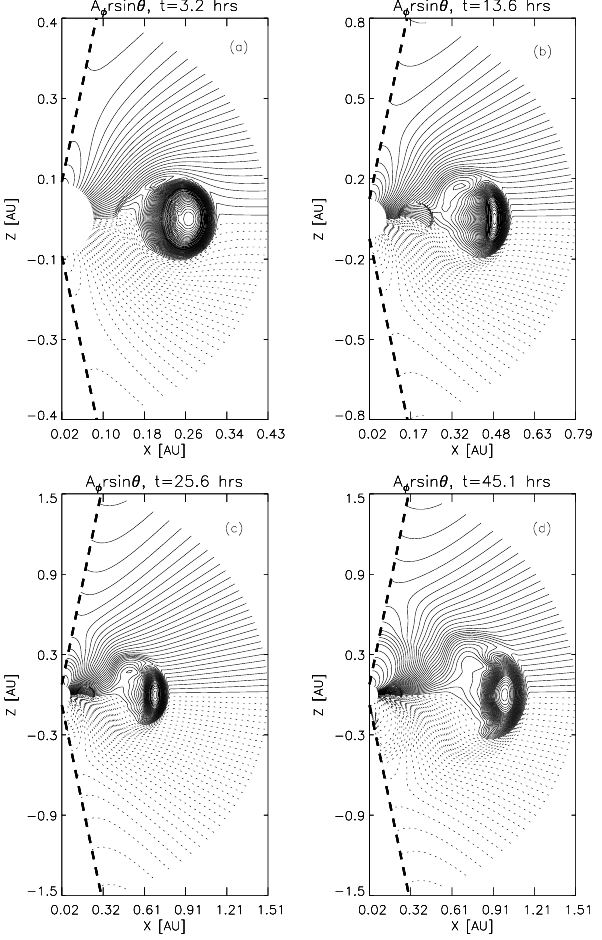
Fig. 8. The evolution of a magnetic flux rope in a radial solar wind magnetic field at four different times. Magnetic field lines projected onto the r − θ plane are shown, with outwardly-directed solar wind field lines being shown as solid (dashed) lines above (below) θ = 0. The ICME field has an anti-clockwise sense of rotation.